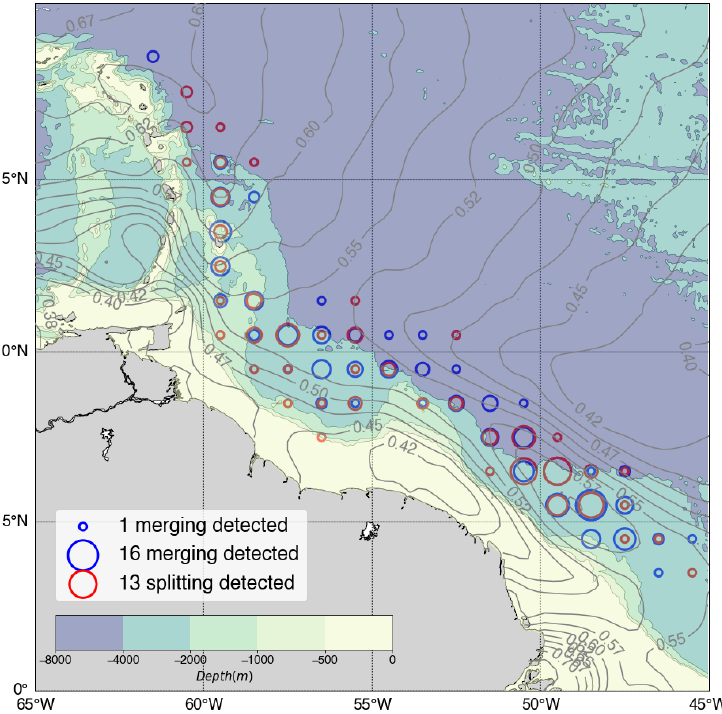
Figure 15. Number of merging (in red) and splitting (in blue) events, with or from NBC rings, in bins of 1° by 1°. The contours of mean dynamic topography are in